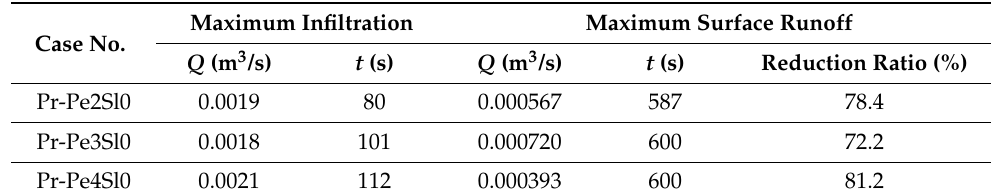
Table 9. Results of permeability variation.